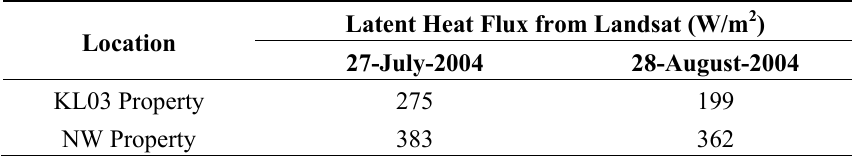
Table 3. Variation in latent heat flux between NW property and KL03 property for July and August Landsat